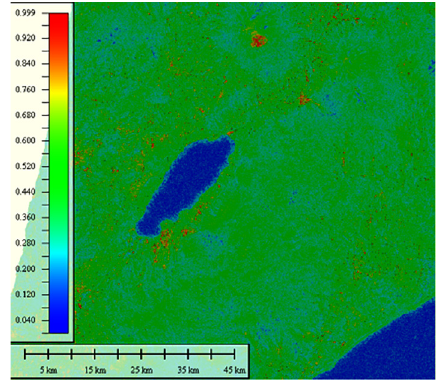
Figure 6. Interferogram of ALOS